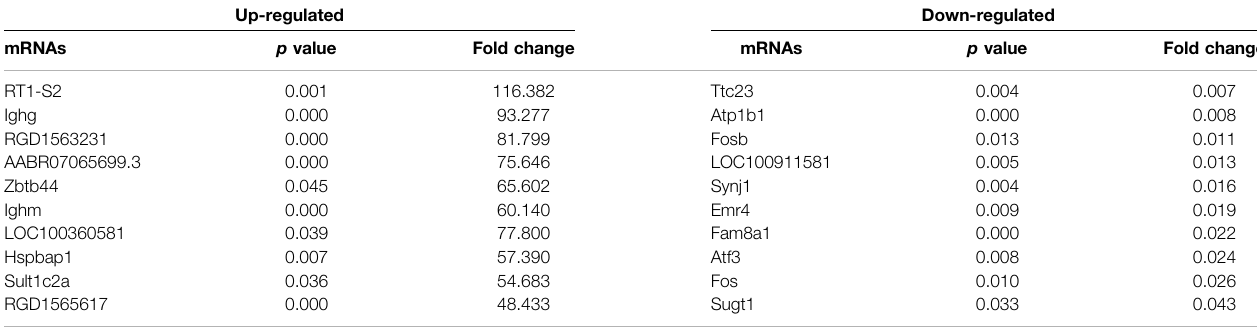
TABLE 2 | Top 10 signi fi cantly differential expressed mRNAs identi fi ed by high-throughput sequencing. Up-regulated Down-regulated